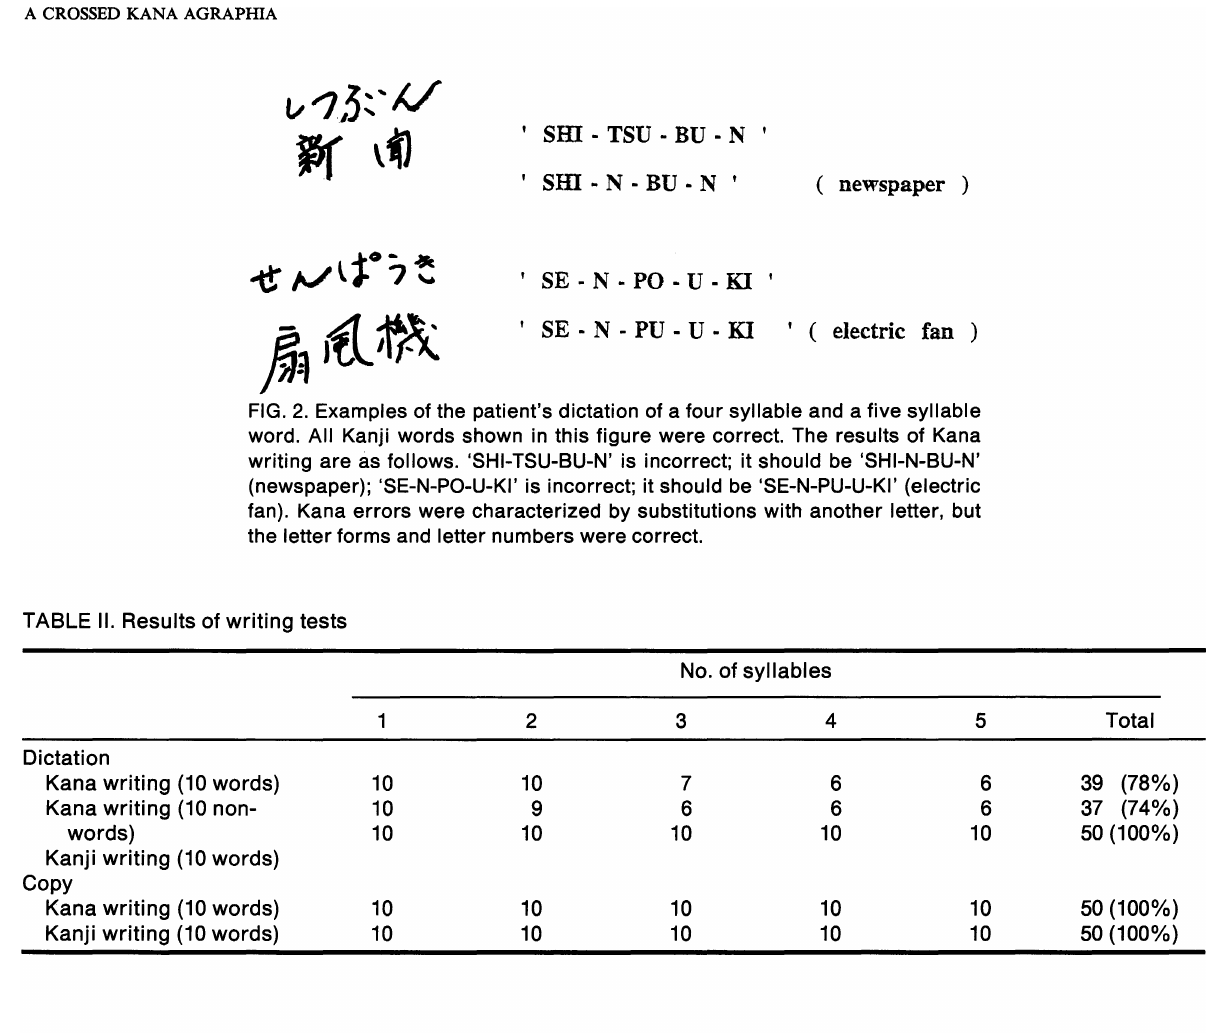
FIG. 2. Examples of the patient's dictation of a four syllable and a five syllable word. All Kanji words shown in this figure were correct. The results of Kana